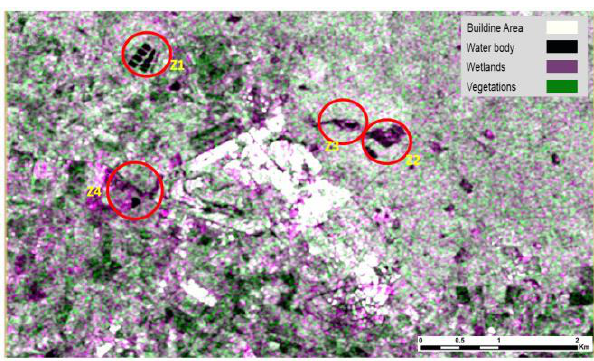
Figure 10. Wetlands identified with Support Vector Machine